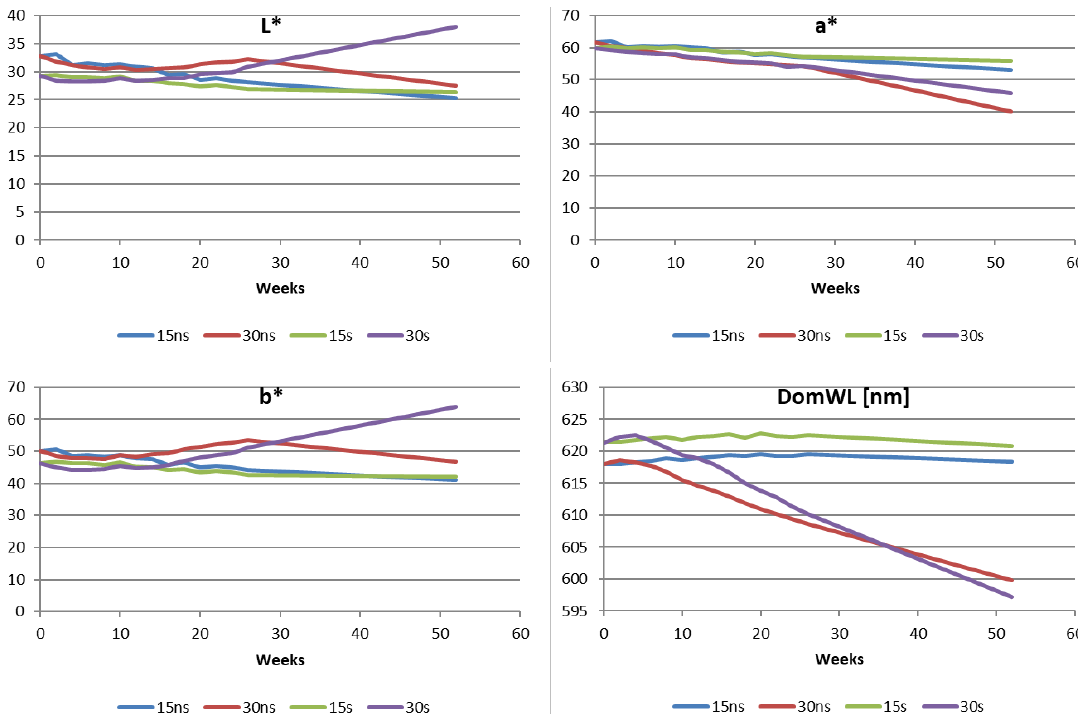
Figure 1. CIELAB chromatic coordinates L* (lightness), a* (red to green), b* (yellow to blue) and DomWL (dominant wavelength) and their changes during storage of liqueurs.